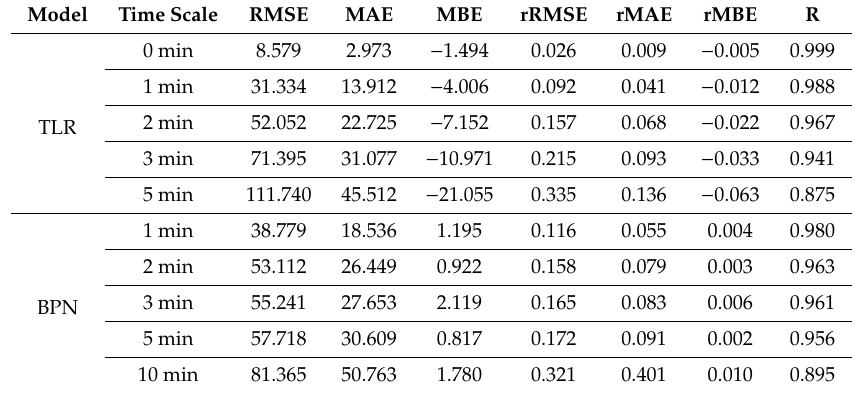
Table 4. Forecasting error comparison between the linear regression model and the neural network model on 11 November 2017.